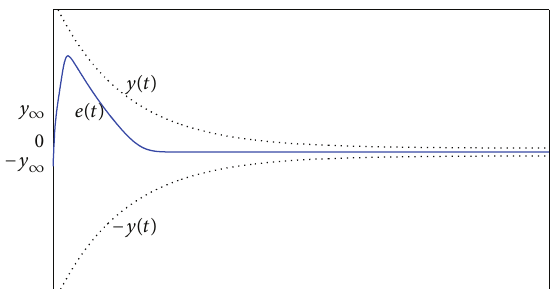
Figure 1: Tracking error prescribed